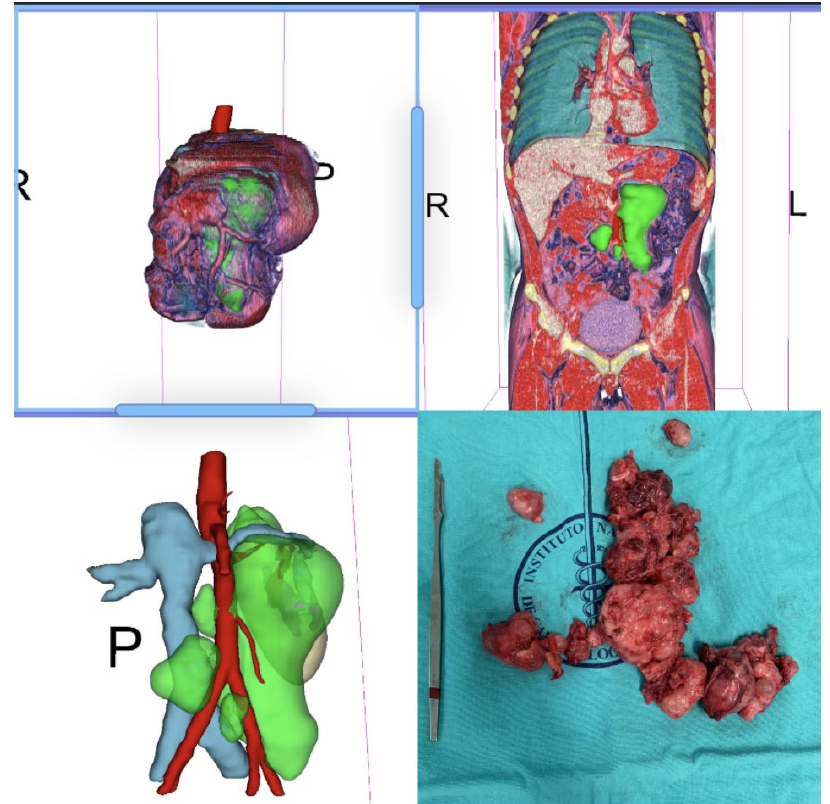
Figure 2. Para and retro-aortic pure post-puberal teratoma, with CT-rendering and 3D reconstruction; the masses were resected without need for adjunctive procedures.